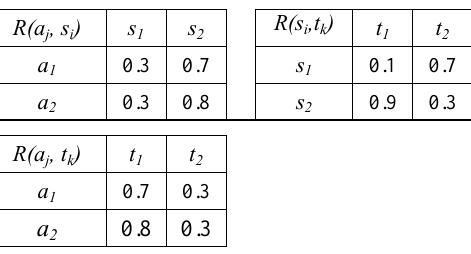
Table 3. Relation of R(s i ,a j ) and R(s i ,t k